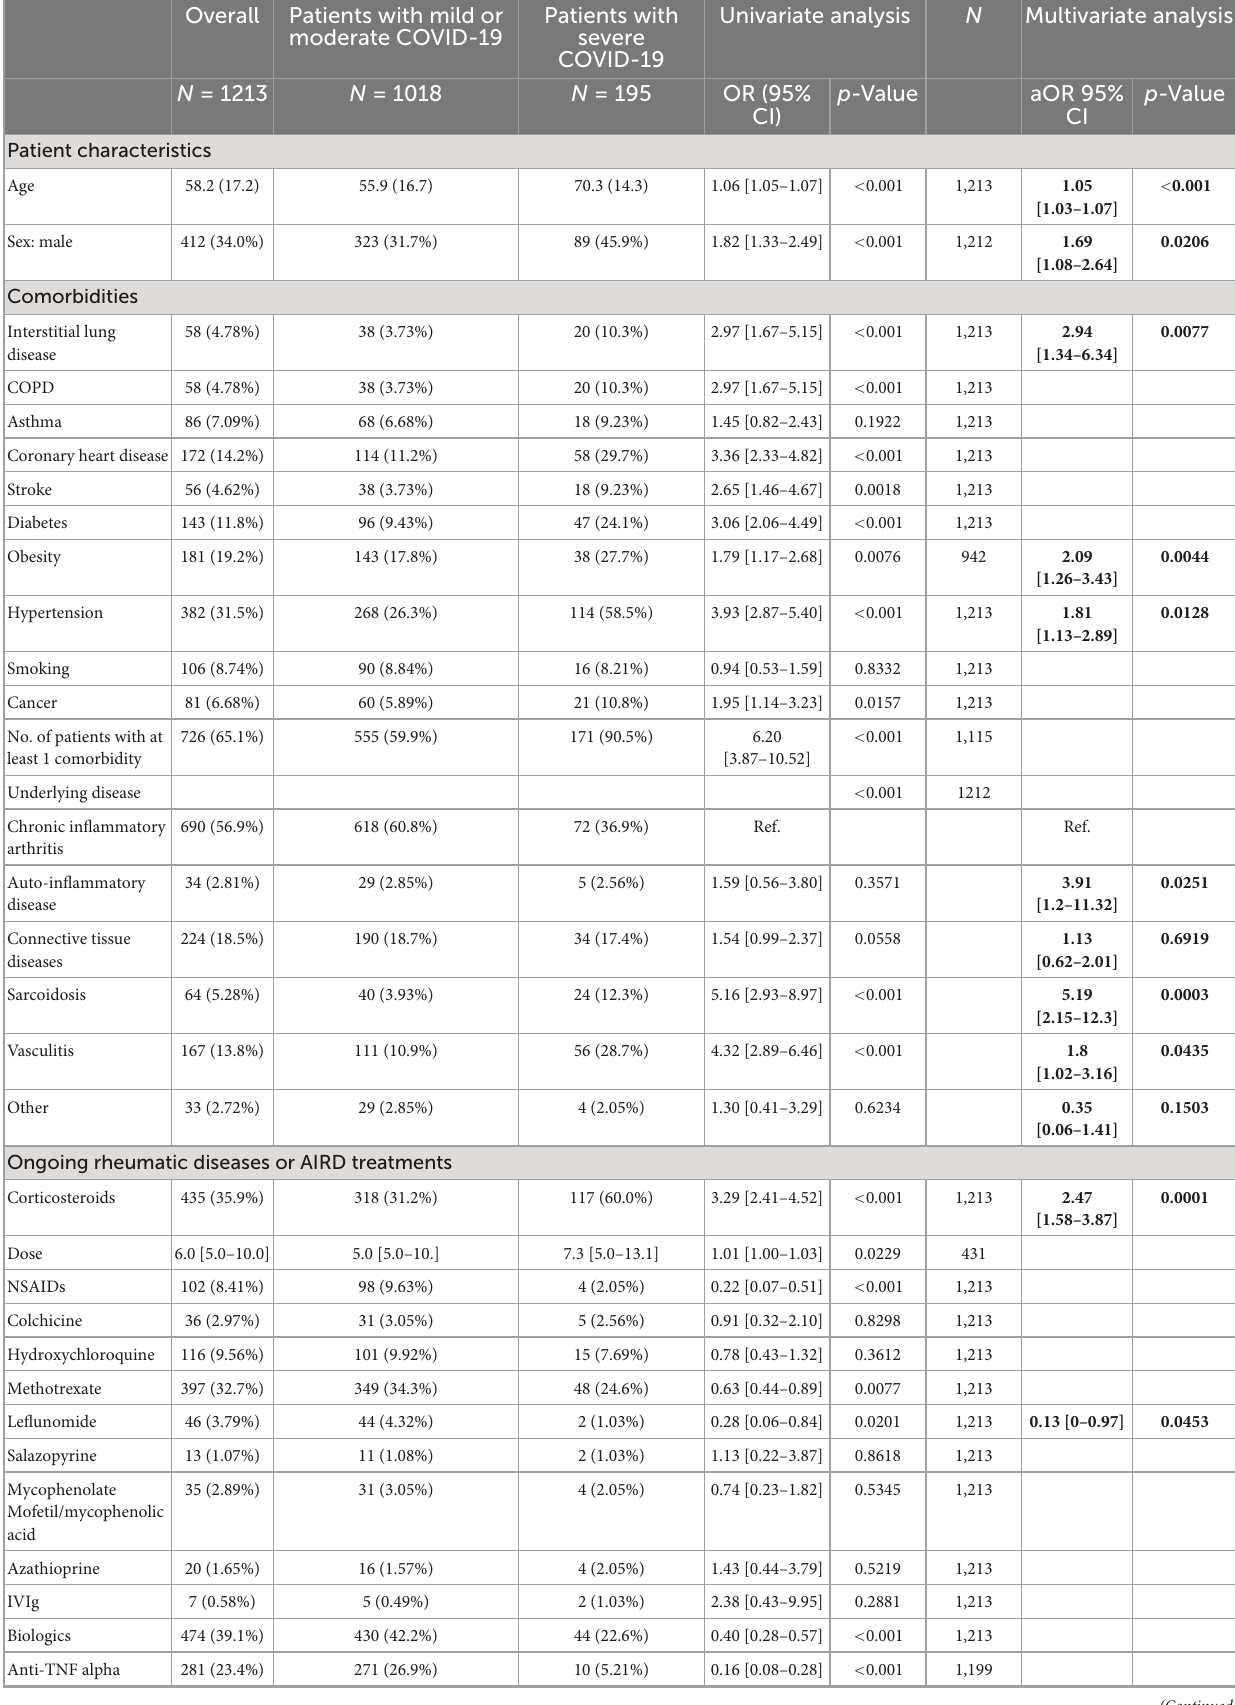
TABLE 2 Factors associated with odds of severe COVID-19 in autoimmune/inflammatory rheumatic disease (AIRD) patients: Pooled analysis of EDS-COVID and the French RMD cohort patients. Overall Patients with mild or Patients with Univariate analysis N Multivariate moderate COVID-19 severe COVID-19